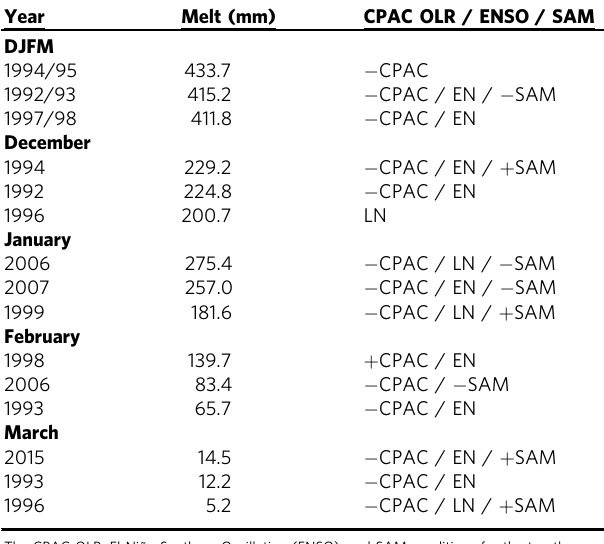
The CPAC OLR, El Niño-Southern Oscillation (ENSO), and SAM conditions for the top three (90th percentile) DJFM and monthly Larsen C surface melt years during 1991 – 2015. Negative (enhanced convection; CPAC OLR ≤ − 0.5 σ ) and positive (suppressed convection; CPAC OLR ≥ 0.5 σ ) CPAC OLR years are labeled as − CPAC and + CPAC, respectively. La Niña (SOI ≥ 0.5 σ ) and El Niño (SOI ≤ − 0.5 σ ) years are labeled as LN and EN, respectively. Positive SAM